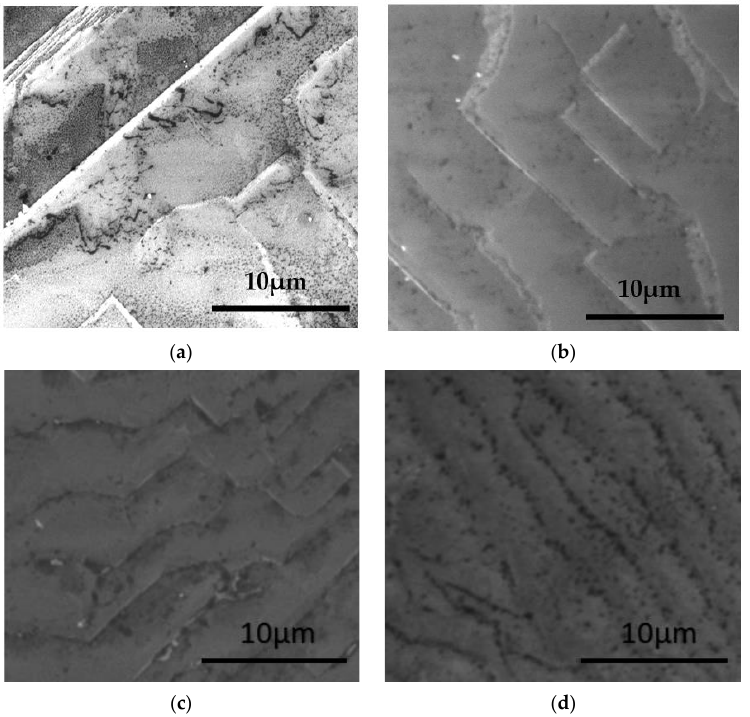
Figure 6. FEG-SEM Images of as-grown MWPACVD diamond films on top of diamond single-crystal seed substrates with different CH 4 gas concentration: ( a ) 6%, ( b ) 8%, ( c ) 10%, and ( d ) 12%.